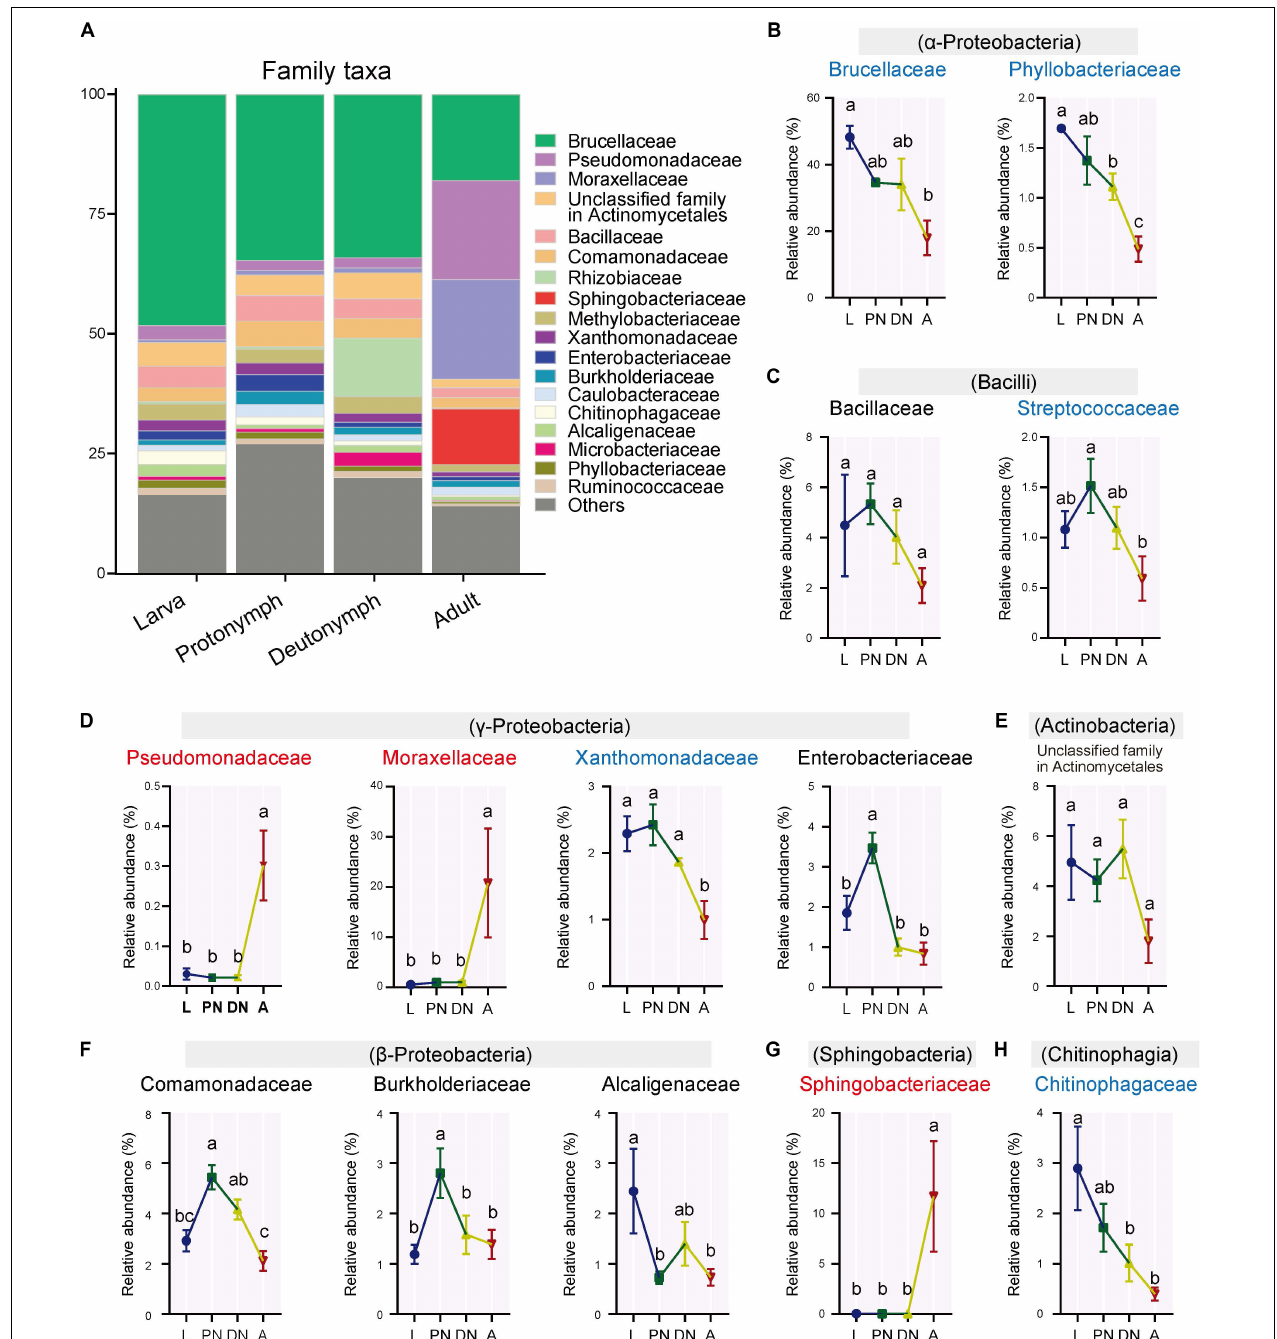
FIGURE 2 | Variations of the relative abundances of bacterial families across the lifespan of P. citri . (A) Whole profiles of the relative abundances of the families in each life stage; only taxa with a relative abundance > 1% in at least one sample were analyzed. (B–H) Comparisons of the relative abundances of 14 major families across the larva (L), protonymph (PN), deutonymph (DN), and adult (A) stages; all n = 3; different lowercase letters denote significant differences between different life stages ( P < 0.05, post hoc DMRT); the family names in red or blue color indicated the relative abundances of corresponding families significantly increased or decreased in the adult stage, respectively; the corresponding classes were presented in parentheses; plots showed means ±